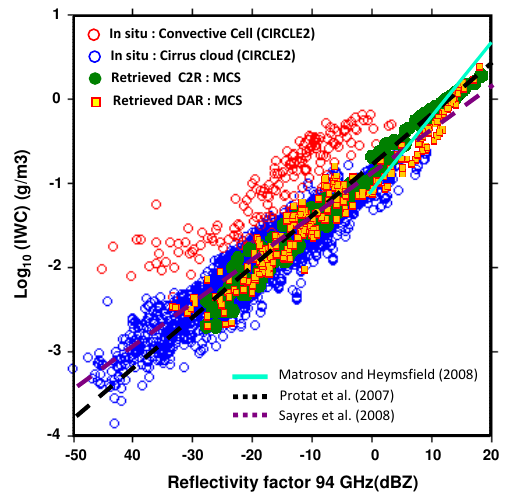
Fig. 8. Retrieved IWC– Z relationship obtained from both the CloudSat 2B-IWC (green symbols) and DARDAR (yellow sym- bols) algorithms for 10700m (FL350) in the MCS system on 20 June 2008. IWC– Z relationships obtained from in situ observations on 26 May 2007 for continental isolated convective cloud and the outflow cirrus observations are red and blue symbols, respectively. The relationships proposed by Matrosov and Heymsfield (2008), Protat et al. (2007) and Sayres et al. (2008) are